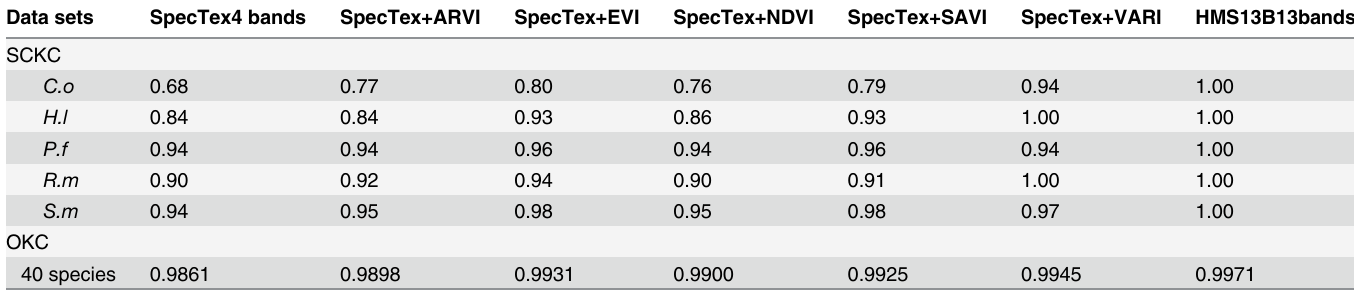
Table 4. Comparisons of the training-samples-based SCKC for the five HCA-species and the OKC for all 40 species in the classification using vari- ous data sets. Data